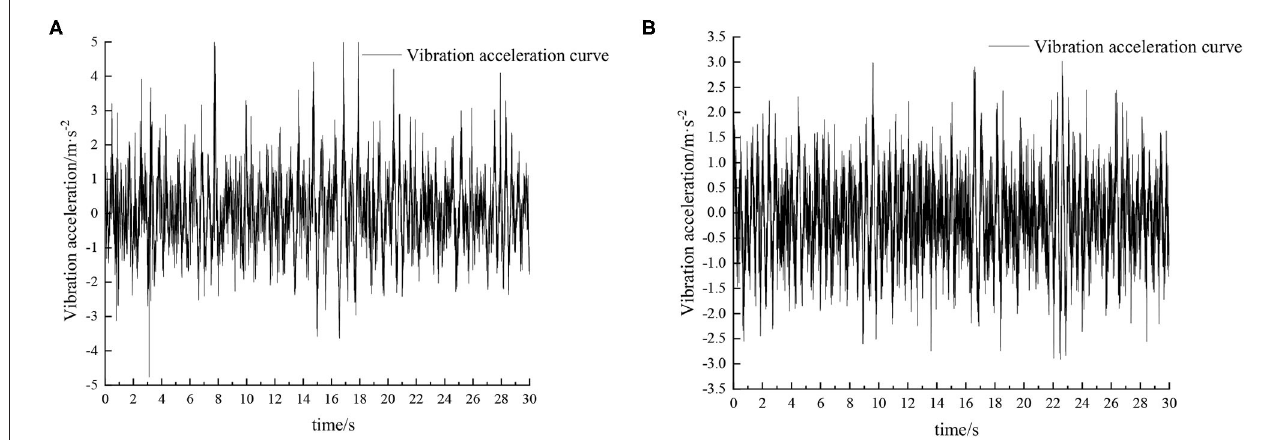
FIGURE 12 | Time domain response curve when driving at 5km/h on sand-gravel road. (A) Passive suspension. (B) Active